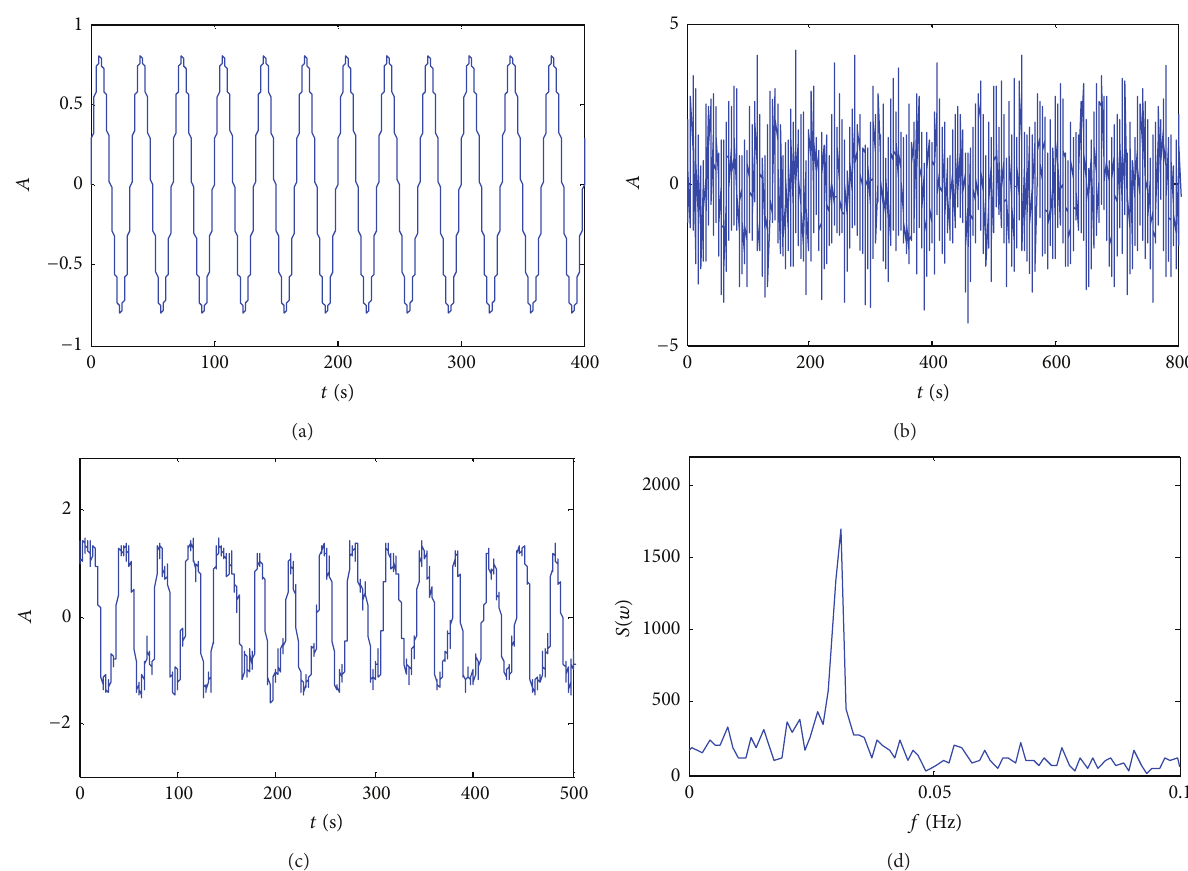
Figure 2: (a) The input signal to be measured. (b) The input signal to be measured contains white Gaussian noise. (c) The stochastic resonance output signal. (d) The spectrum figure of the stochastic resonance output signal.